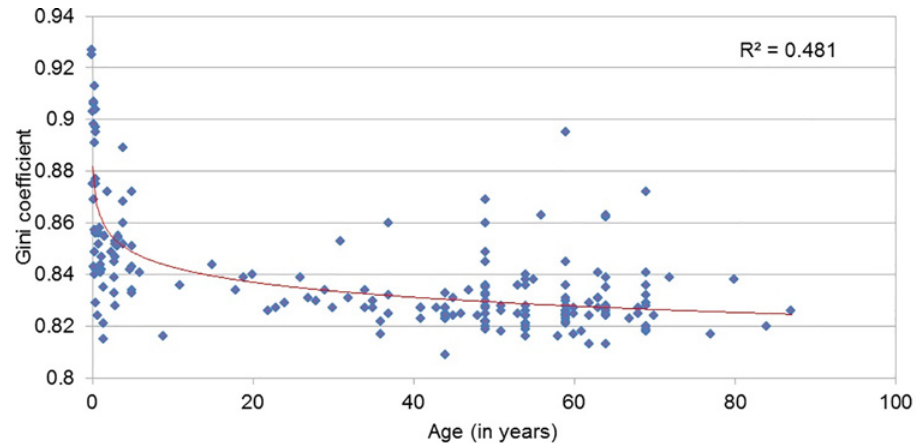
Fig 2. Variation of contribution index (expressed as GINI coefficient) of CAZyme families in the human gut with age. The GINI coefficient, an indicator of functional rarefaction, varies as a logarithmic function with age. Adult individuals have a lower GINI coefficient, indicating more equal distribution of CAZyme families, but with progressively younger age, fewer CAZyme families contribute to a greater proportion of CAZymes, thereby increasing the GINI coefficient. Also, high GINI coefficients, close to a maximum of 1, indicate frequency distribution of CAZyme families is highly non-uniform.